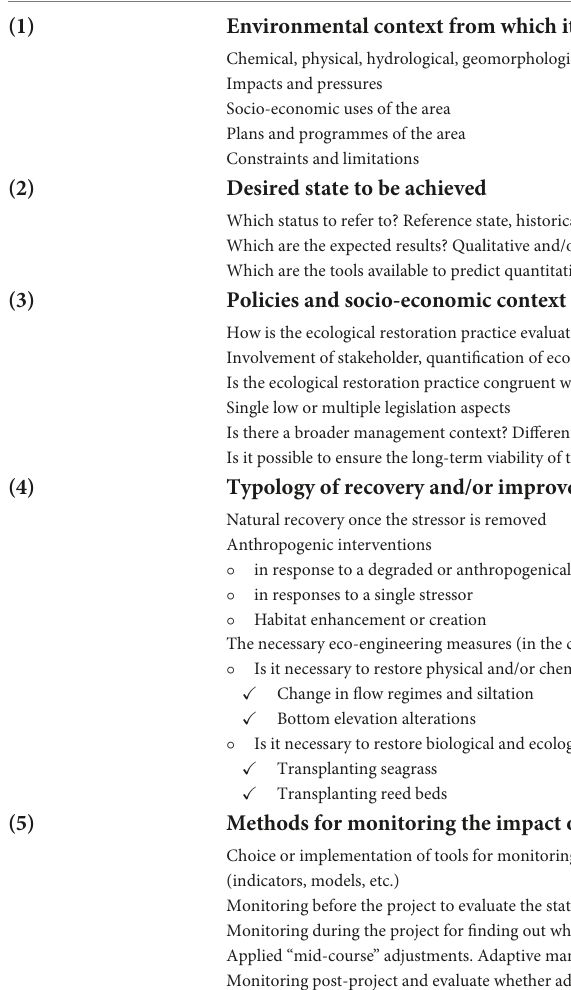
TABLE 1 Elaboration of the theoretical elements from literature (see reference in the